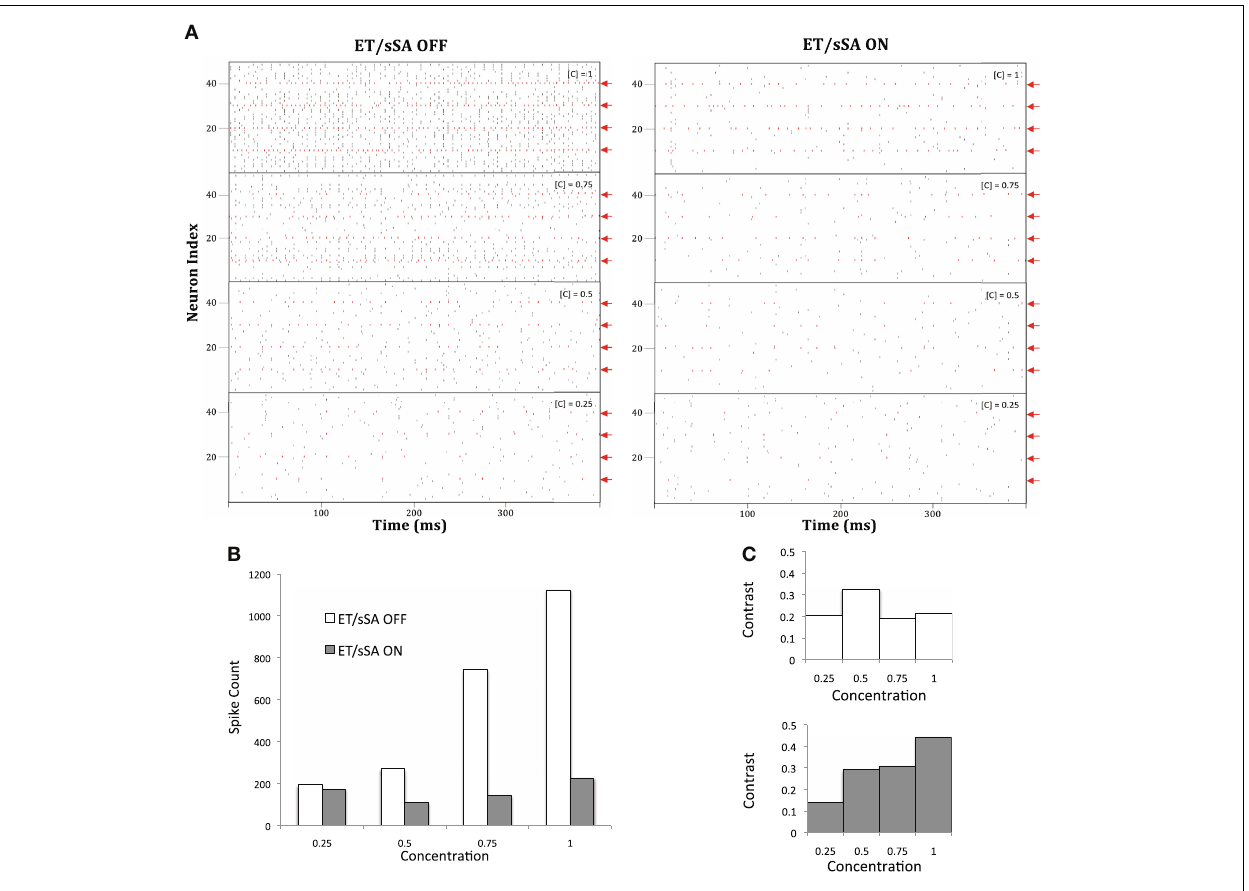
in red) was plotted against odor concentration.The inhibitory effects of the ET/sSA network limit or prevent firing in more weakly tuned mitral cells, such as those that are recruited only at higher odor concentrations. At high concentration the normalizing effects reduce the spike count by as much as 80%. (C) Effects of ET/sSA network normalization on contrast enhancement. Contrast was calculated as the total number of spikes in the most strongly tuned neurons divided by the total number of spikes in the population.With the ET/sSA network disconnected (top), the recruitment of weakly tuned mitral cells by elevated odor concentrations prevents improvements in contrast across mitral cell population activity. With the ET/sSA network active (bottom), increases in concentration result in net inhibition of marginally activated neurons, increasing the contrast between them and the most strongly activated